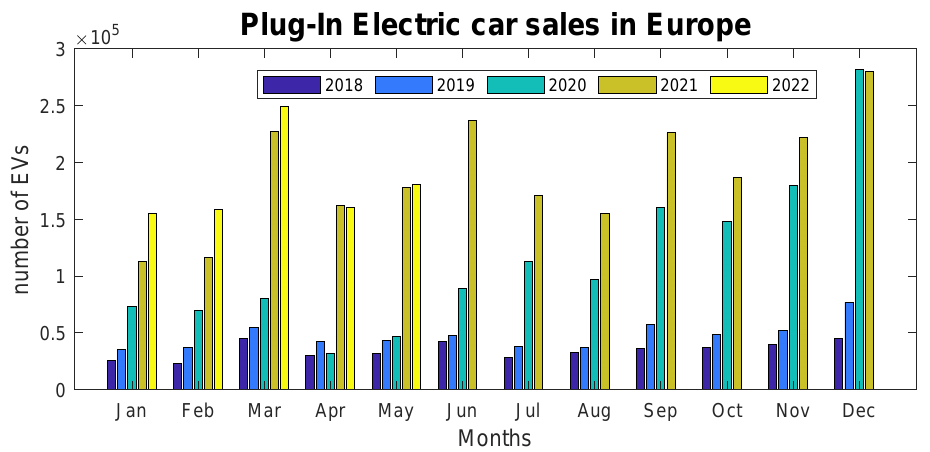
Figure 1. Production of EVs in Europe